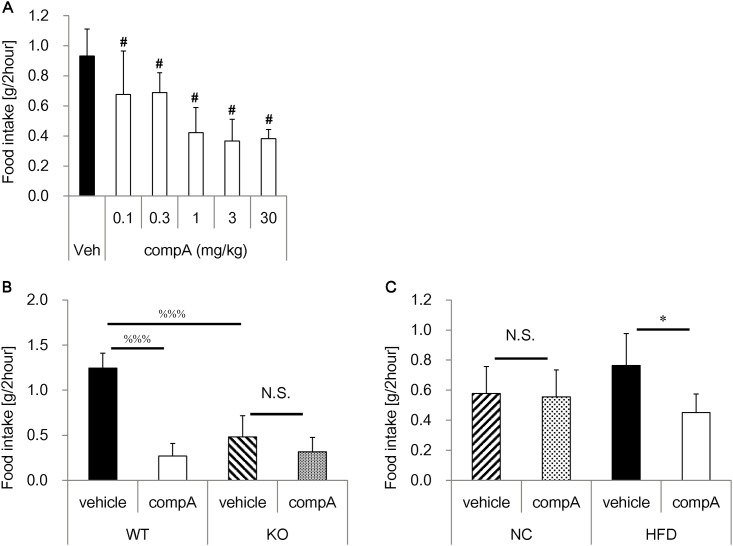
Acute anorectic effect of compA under high-fat diet (HFD)-feeding conditions.Fasted mice were orally administrated vehicle or compA and were fed either HFD or normal chow (NC) for 2 h. (A) Amount of HFD intake by C57BL/6J mice. (B) Amount of HFD intake by vehicle or 10 mg/kg compA-treated MGAT2 KO mice and WT littermates. (C) Amount of NC or HFD intake by vehicle or 10 mg/kg compA-treated C57BL/6J mice. n = 5 (A, B) or n = 7 (C). #: P < 0.025 vs. vehicle group by one-tailed Williams’ test. %%%: P < 0.001 vs. vehicle-administrated WT mice by Student’s t-test. *: P < 0.05 vs. HFD-fed vehicle group by Student's t-test. N.S.: not significant.